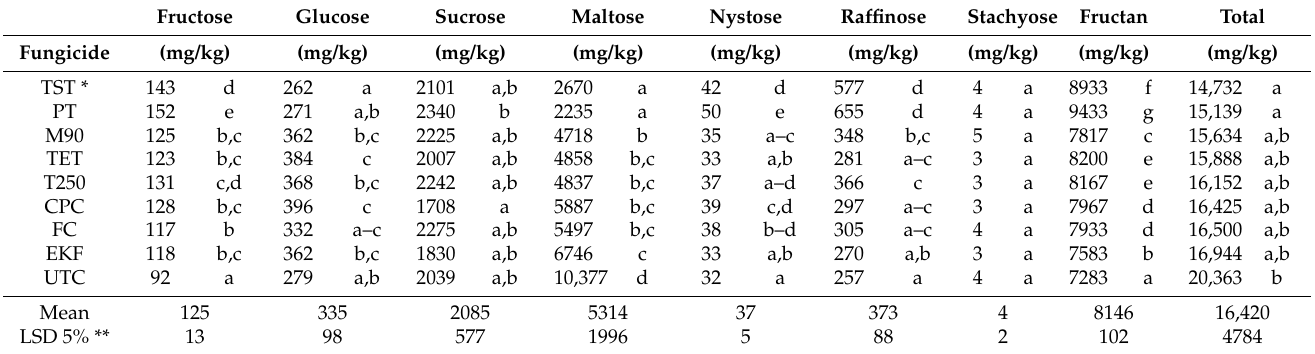
Table 2. Water soluble carbohydrate content in wheat flour samples treated with various fungicides in a Fusarium epidemic year (2010); results are the average of three wheat